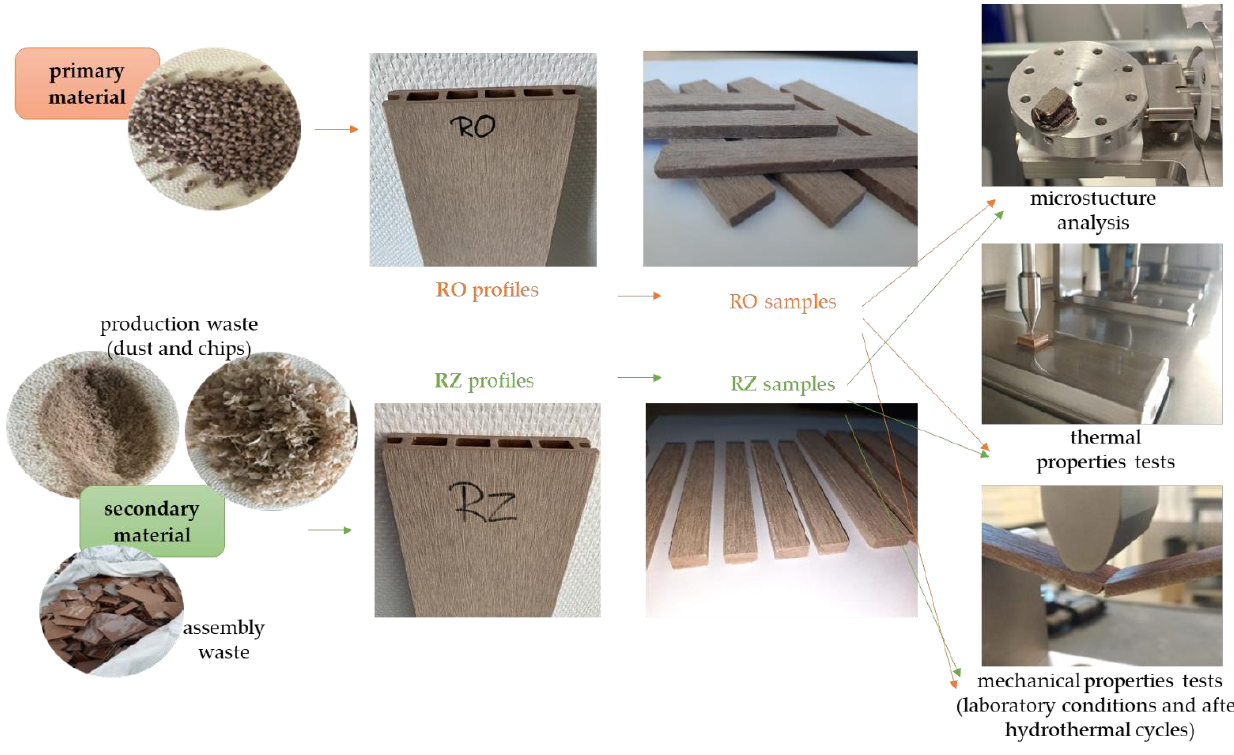
Figure 2. Experimental flowchart with photos.